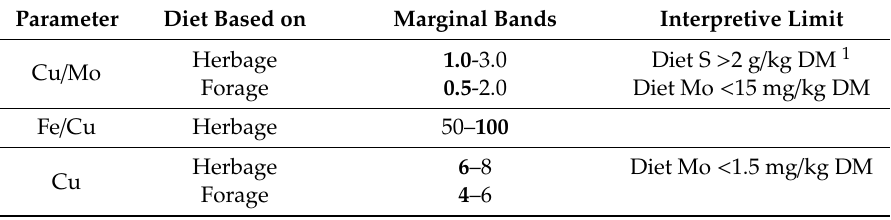
Table 1. Marginal bands for copper antagonist concentrations in the diet to aid the diagnosis of copper response disorders (CRD) in cattle fed on fresh herbage or forage-based diets (adapted from Suttle [6]). Marginal bands indicate the probability of CRD, which increases with proximity to the value shown in bold. Parameter Diet Based on Marginal Bands Interpretive Limit Herbage 1.0 -3.0 Diet S > 2 g / kg DM 1 Cu / Mo Forage 0.5 -2.0 Diet Mo < 15 mg / kg DM Fe / Cu Herbage 50– 100 Herbage 6 –8 Cu